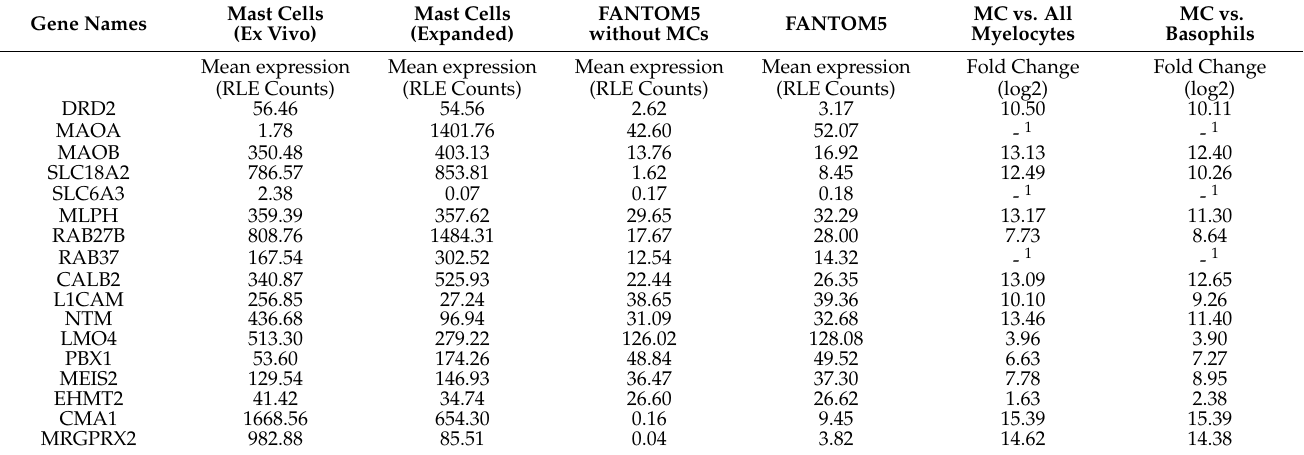
Table 1. Expression of selected gene sets and their comparison between mast cells and myelocytes or basophils. The expression data were extracted from Motakis et al. (2014) [49] and presented as RLE-normalized counts. Here, gene expression of skin-derived MCs was studied in parallel with ~400 different cell types from different tissues, using CAGE-seq analysis. This study provided the most comprehensive overview of the human MC transcriptome ever reported. Fold changes of differentially expressed genes were taken from Babina et al. (2014) [76]. Hereby, the MC transcriptome was compared with different blood cell types from the FANTOM5 project combined (i.e., not only MCs versus a single cell type, but MCs versus an overall myelocytic signature). CMA1 and MRGPRX2 are not discussed herein but were added for comparison as MC-selective entities. RLE Counts: Relative Log Expression (RLE)-based normalized counts by the means of